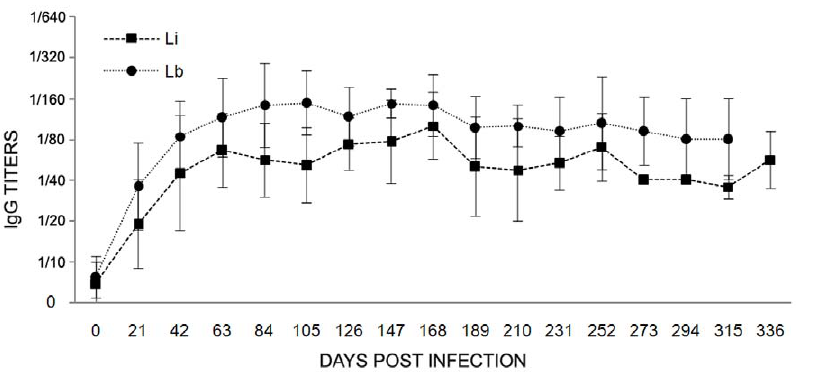
Figure 4. Kinetics of the humoral immune response (IFAT) in Thrichomyslaurentius experimentally infected by Leishmaniabraziliensis (Lb) or Leishmaniainfantum (Li). Each point represents the mean value and standard errors of the IgG titers of infected rodents.